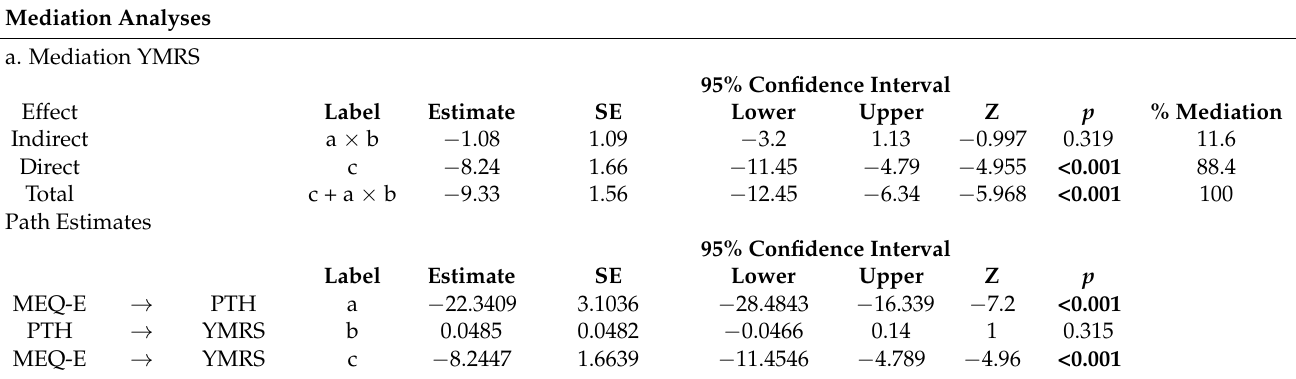
Table 5. (a) Mediation Analyses. (b) Mediation HAM-D. (c) Mediation